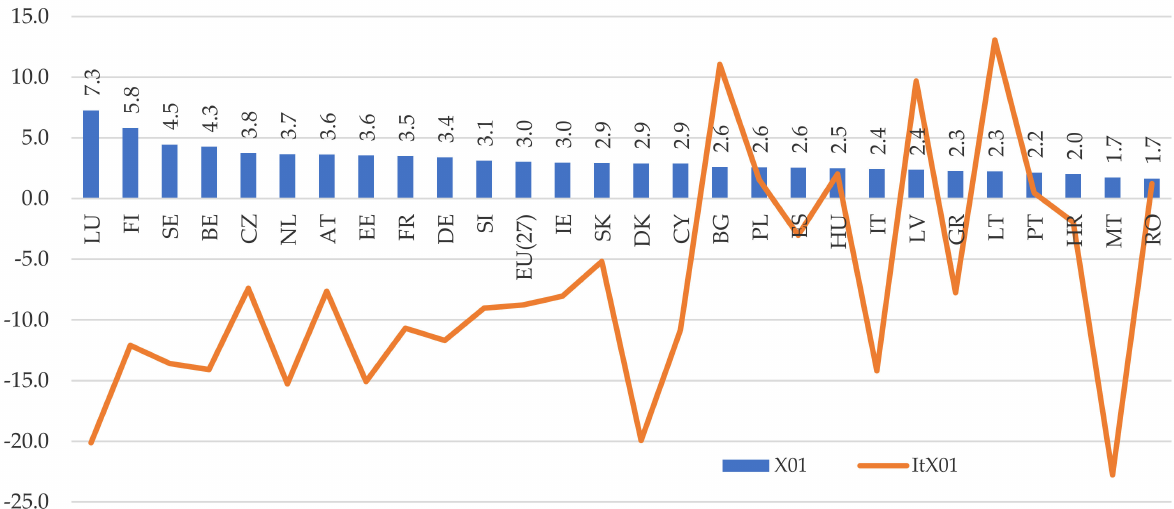
Figure 1. A ranking of EU (27) countries according to their primary energy consumption in tonnes of oil equivalent per inhabitant (X 01 ) in 2019 and index I tX01 for 2019 (2010 = 100). Source: own work based on